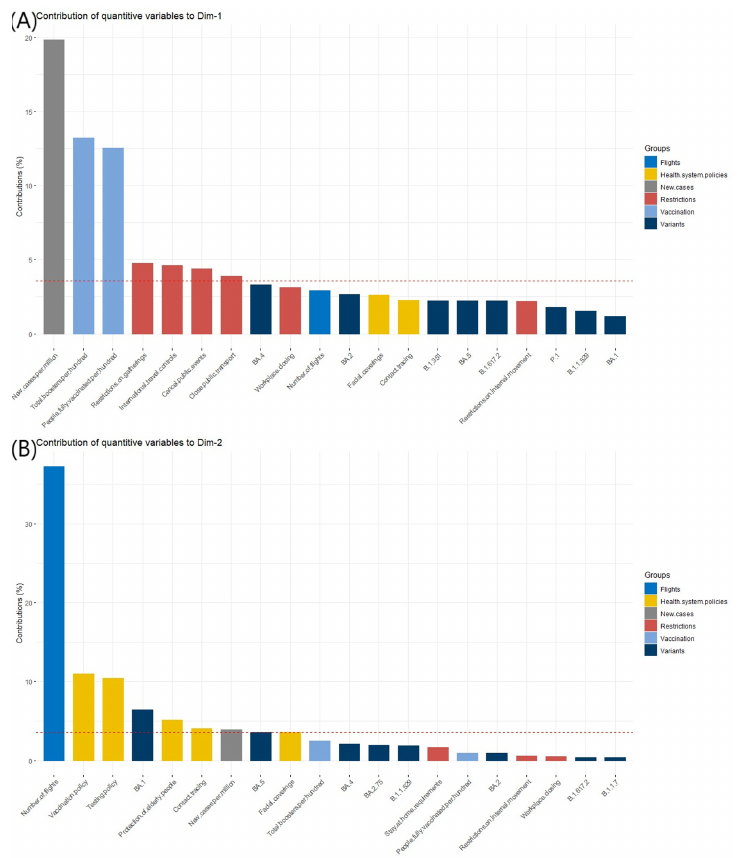
Figure 3. The contribution of quantitative variables to the definition of the dimensions. ( A ) contri- bution of quantitative variables to Dim-1; ( B ) contribution of quantitative variables to